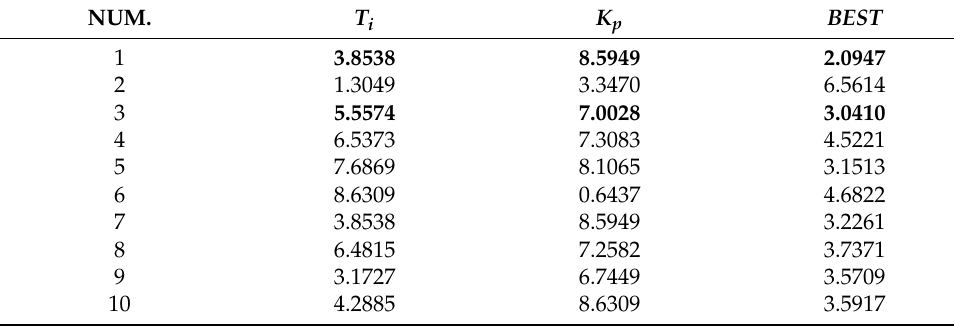
Table 2. Results of control PI using ABC optimization.